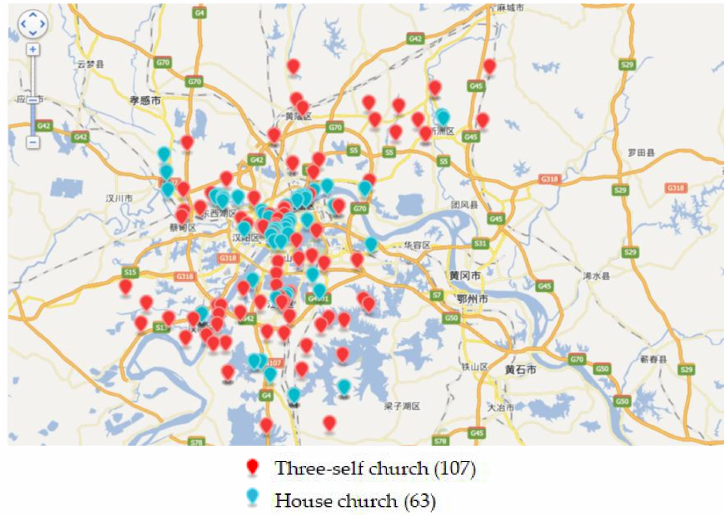
Figure 4. The distribution of Christian churches in the city of